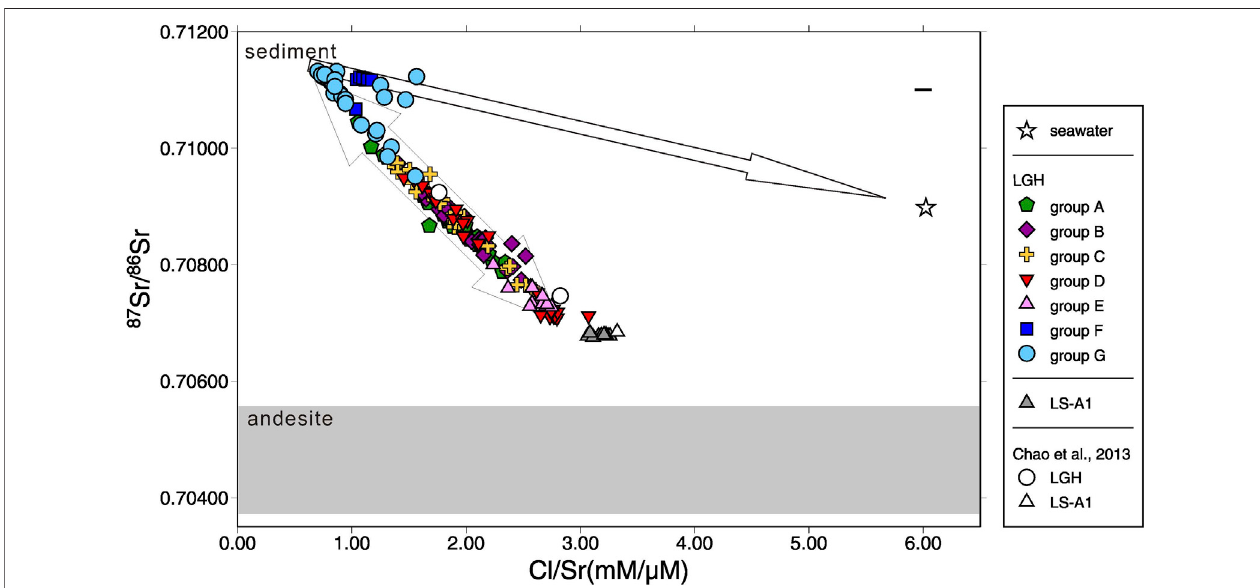
FIGURE4| Plotof 87 Sr/ 86 Srvs.Cl/Srratioforallmudvolcano fl uidsinthisstudy.Seawatercomposition,literatureresults(Chaoetal.,2013),andthearcbasement (andesite; shaded area) are shown for reference. The range of andesite 87 Sr/ 86 Sr is adopted from Chen et al. (1990) and Bentahila et al. (2008). Variation of the ancient seawater since 5 Ma is smaller than the symbol. The range of the cross denotes the range of the reproducibility (2 σ ).